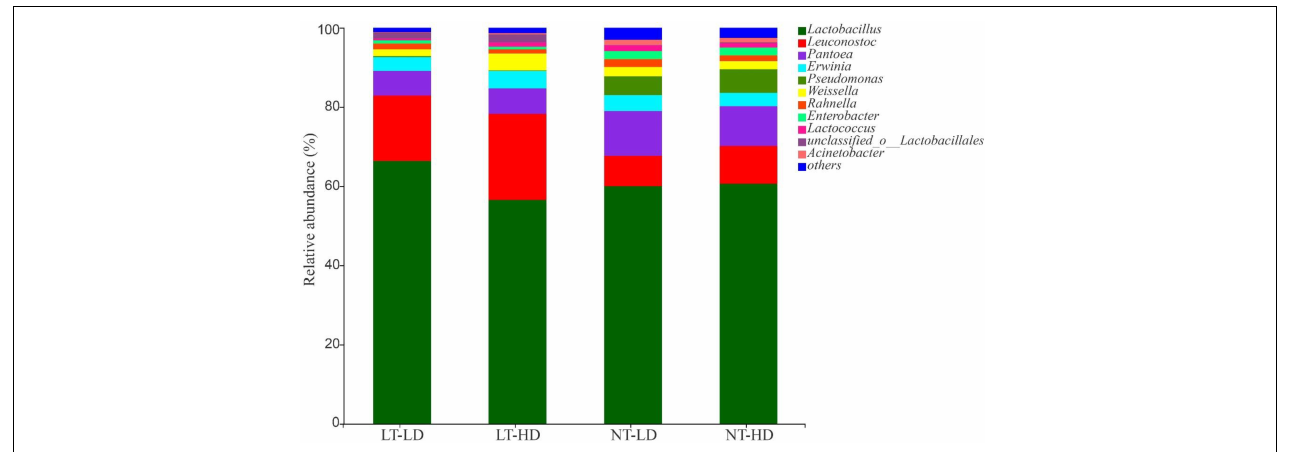
FIGURE 2 | Bacterial community (genus level) of sorghum-sudangrass silage ( n = 3). LT, storage temperature at 10 ◦ C; NT, storage temperature at 25 ◦ C; LD, ensiling density at 550 kg/m 3 ; HD, ensiling density at 650 kg/m 3 .